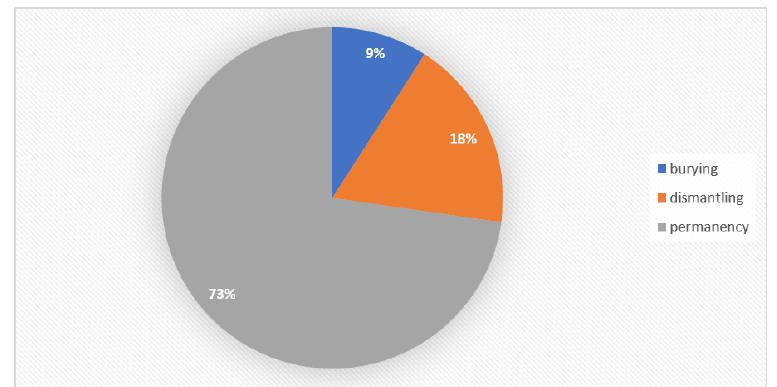
Figure 6. Urban action on railway tracks. Own elaboration.